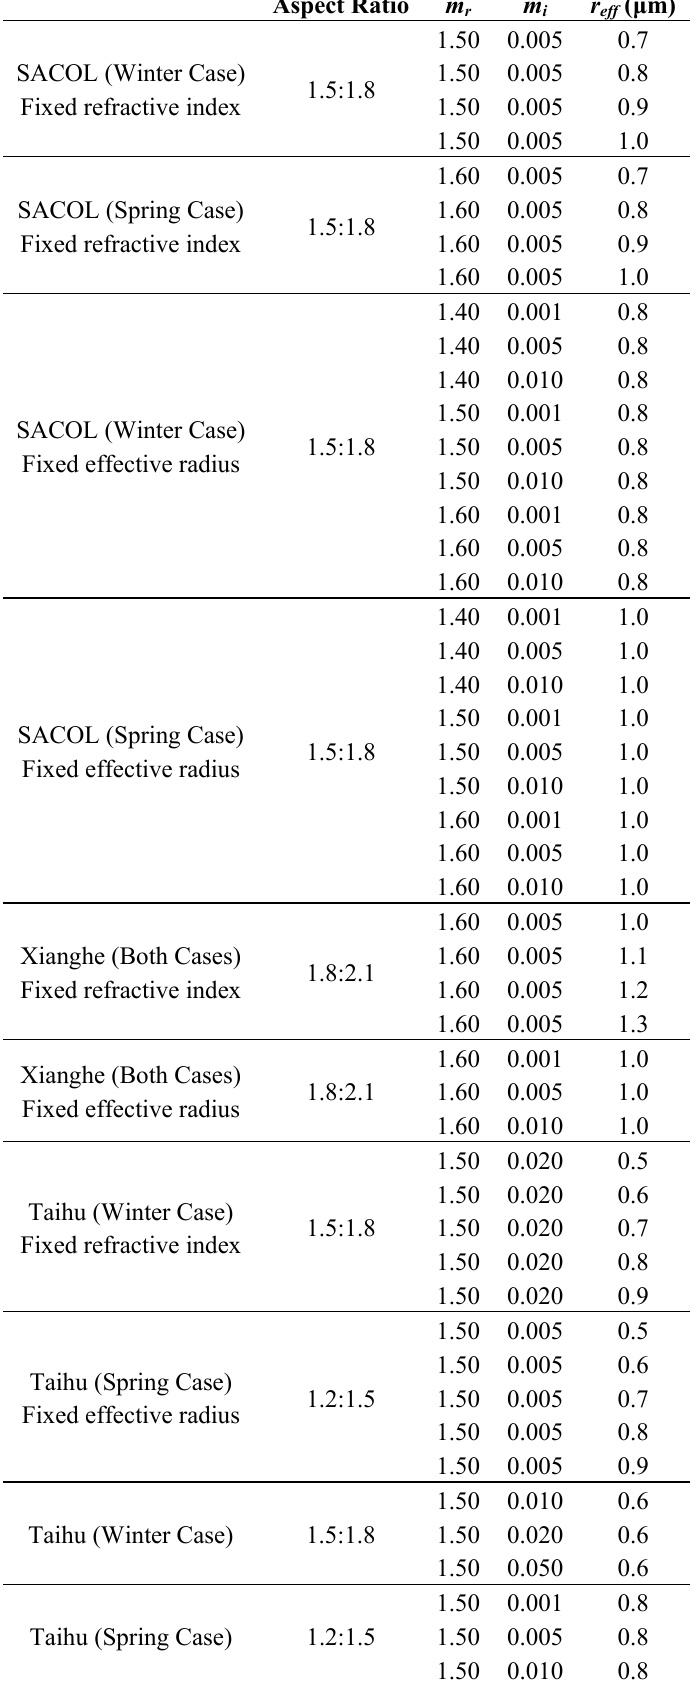
Table 2. Summary of the theoretical model parameters used in this